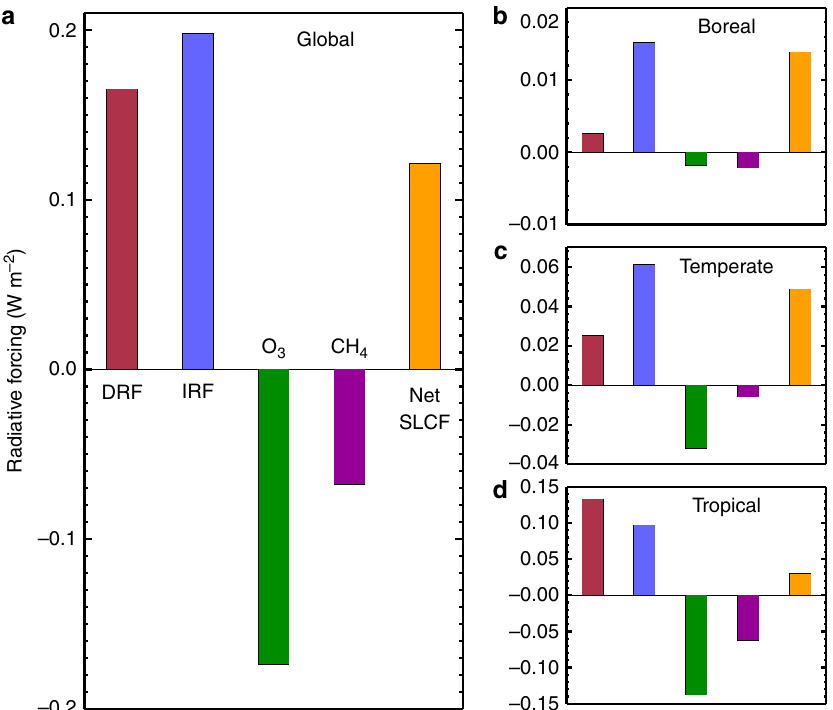
Fig. 1 Global annual mean radiative forcings due to changes in the concentrations of short-lived climate forcers (SLCFs) under global ( a ) and regional ( b – d ) deforestation scenarios. Bars represent the net radiative forcing from SLCFs (orange) and the aerosol direct radiative forcing (DRF; in red), fi rst aerosol indirect radiative forcing (IRF; in blue) and RF due to changes in O 3 (green) and CH 4 (purple)